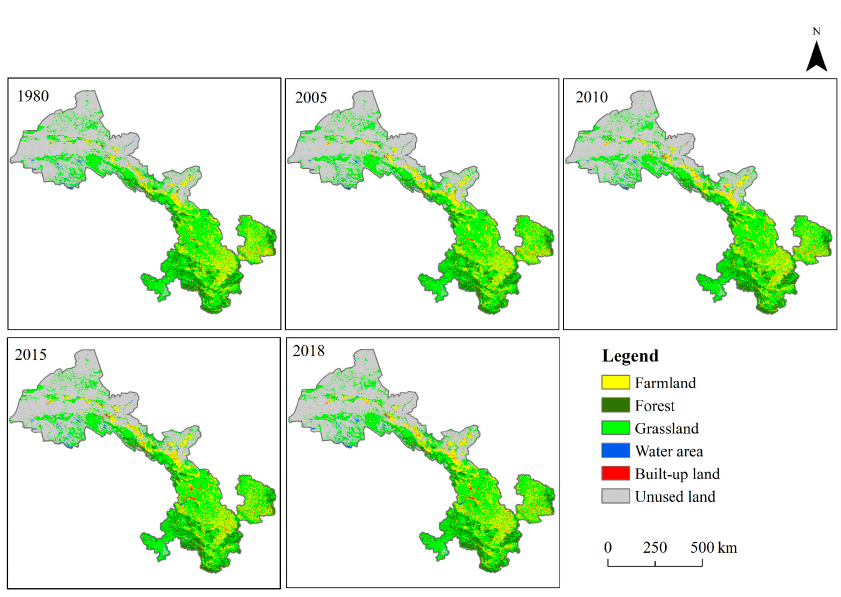
Figure 2. Land use and cover maps for 1980, 2005, 2010, 2015, and 2018.